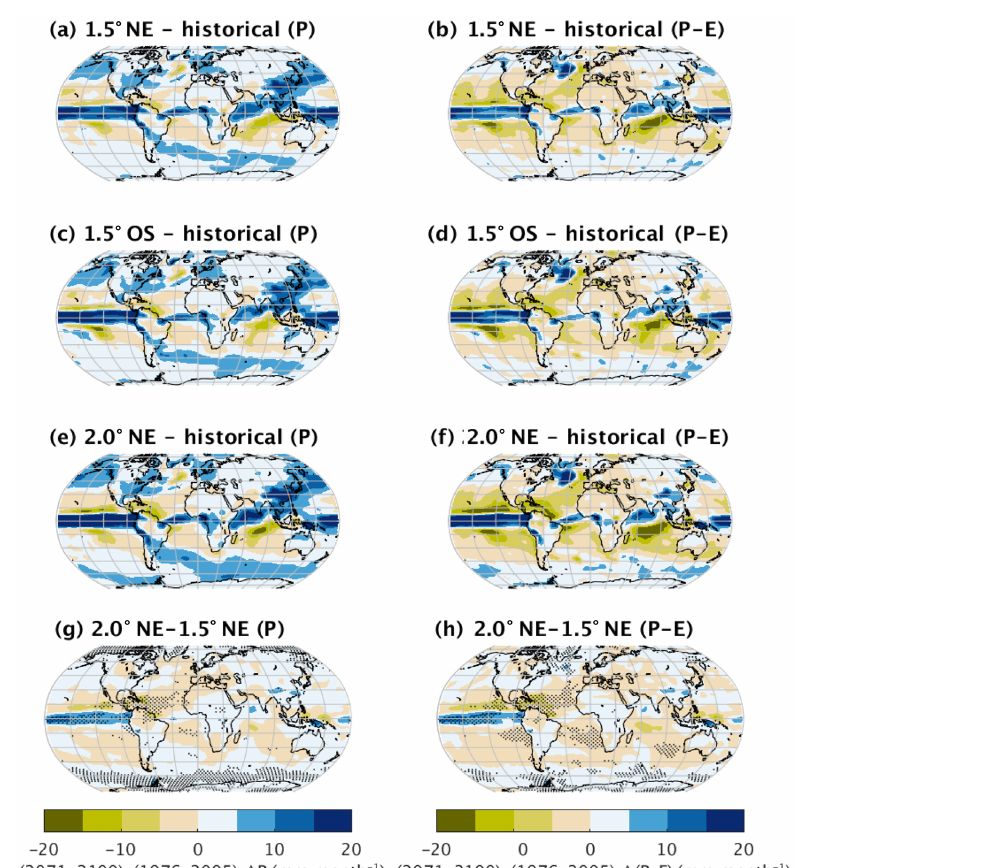
Figure 7. Maps showing ensemble mean 2071–2100 precipitation (P) and precipitation–evaporation (P–E) changes from 1976–2005 his- torical conditions in 1.5degNE (a, b) , 1.5degOS (c, d) , and 2.0degNE (e, f) scenarios. Subplots (g, h) show the difference between mean 2080–2100 conditions in 1.5degNE and 2.0degNE, where significant regions are stippled. Significance is defined as a pixel in which the difference between the mean of the 2.0degNE and 1.5degNE ensembles exceeds the SD of 2080–2100 values in the 2.0degNE